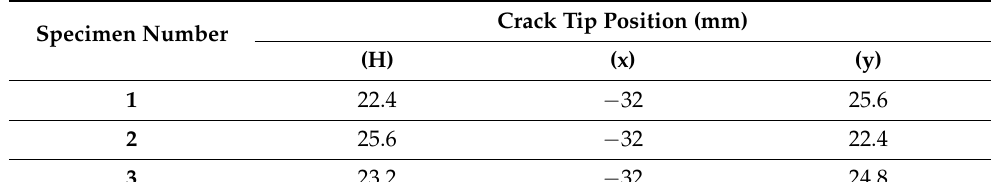
Table 2. Pre-crack position for the modified compact tension.